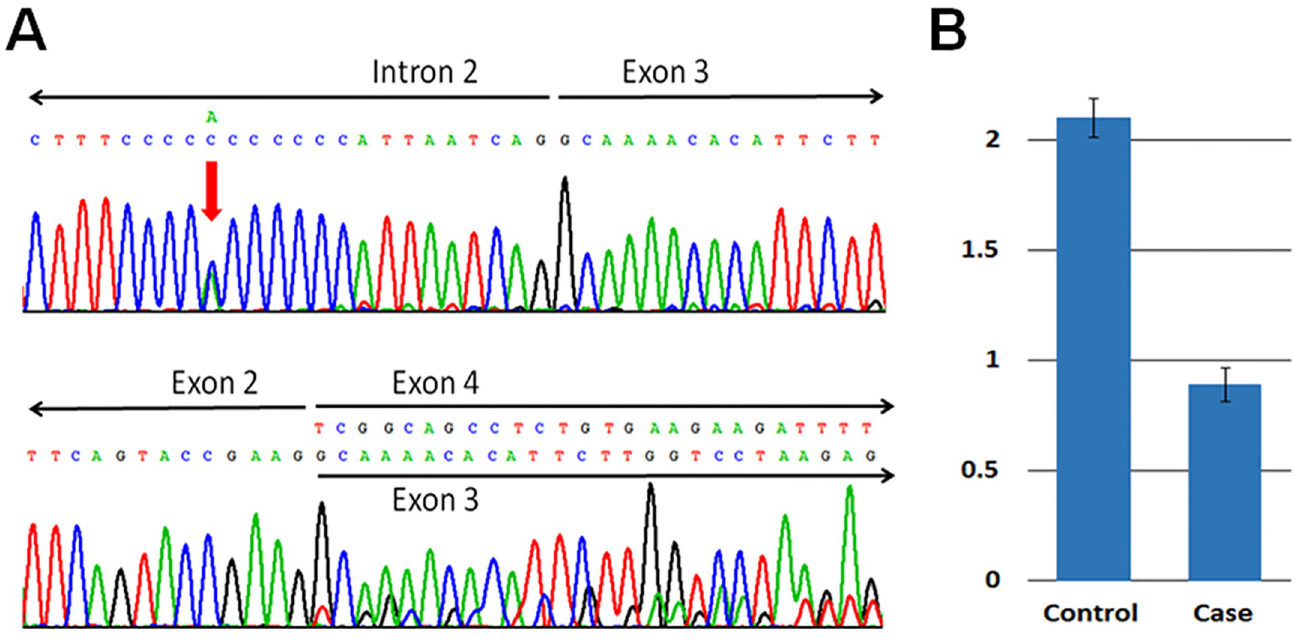
Fig 1. Genetic study of the LBSL patient. A DARS2 mutation c.228–16 C > A (upper panel, indicated by arrow) in intron 2 was identified, which causing a DARS2 mRNA transcript lacking exon 3 (lower panel); (B) TaqMan copy number assay (vertical bars indicating the ranges of values) for DARS2 exon 12 showed loss of a copy of exon